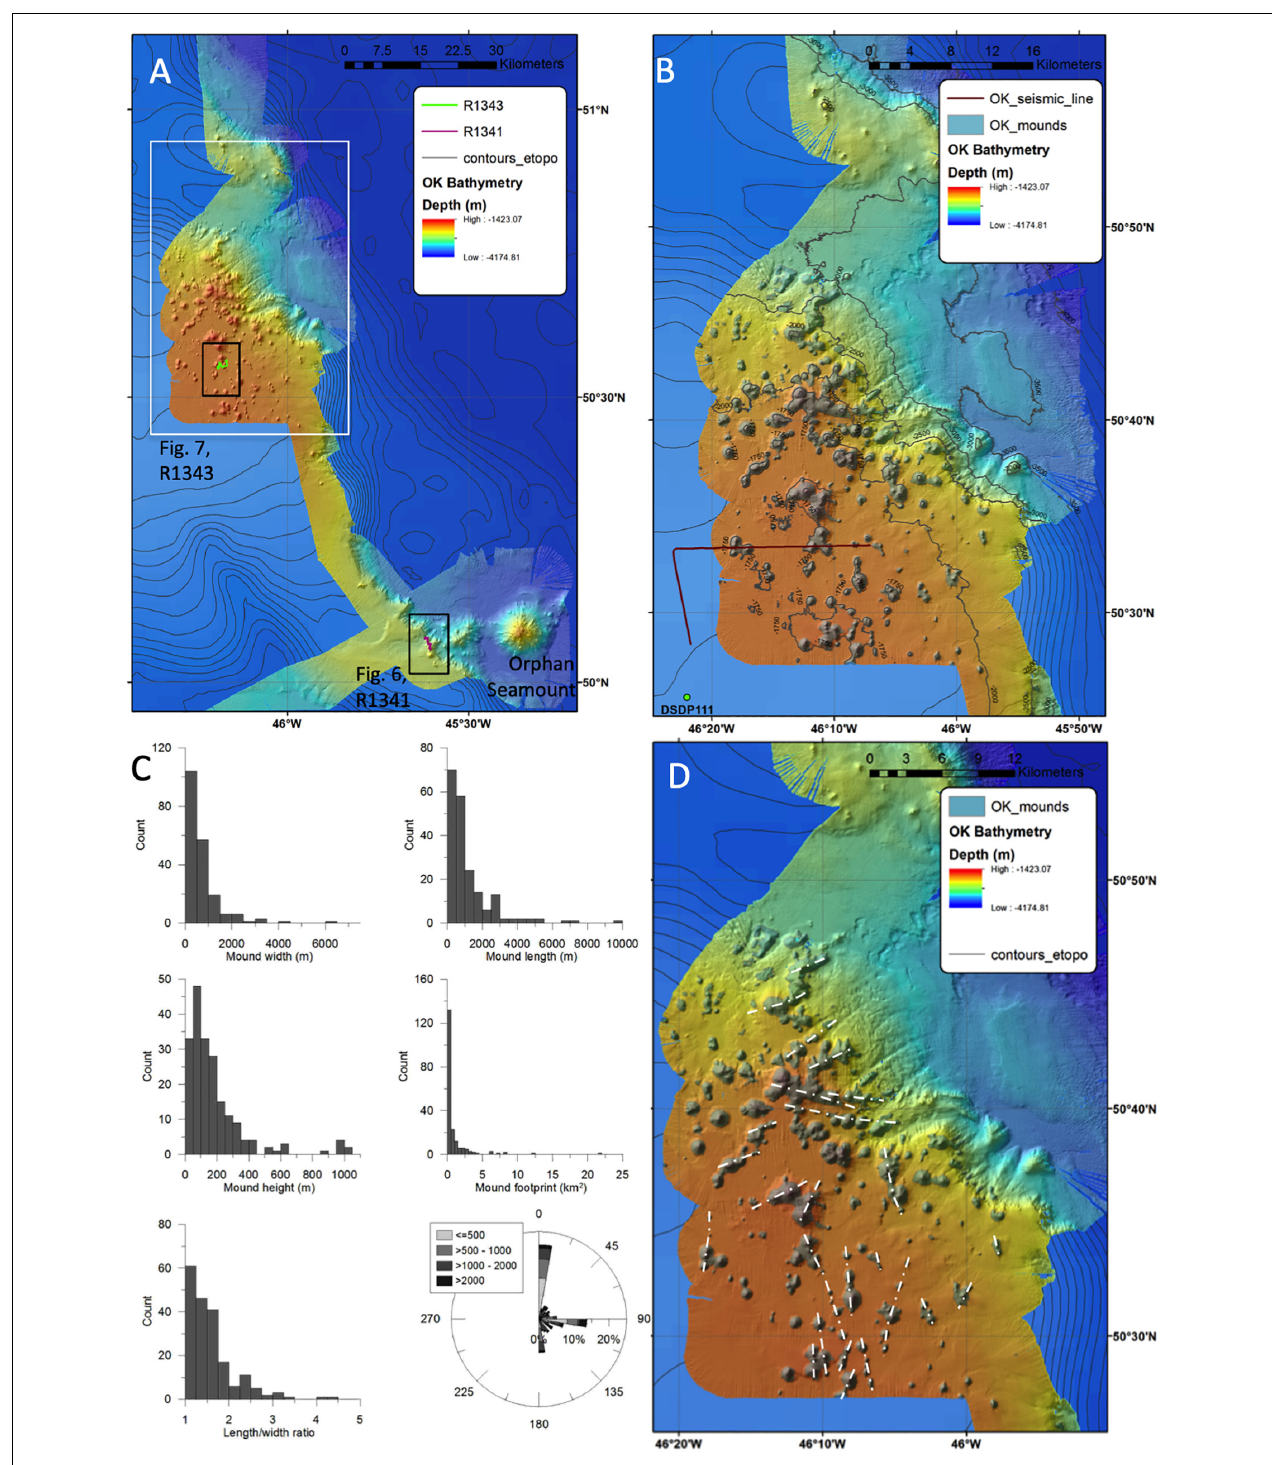
FIGURE 5 | (A) Overview map of the ICY-LAB bathymetry data set over Orphan Knoll. White box indicates are enclosed in right-hand panel (B) . Two dark boxes indicate close-up bathymetry shown in Figures 6A , 7A. (B) Zoom on the central part of the map, illustrating the results of the automated mound mapping exercise over northeast Orphan Knoll. Also shown are the locations of the sub-bottom profile line in Figure 4 , and the location of DSDP site 111. (C) Mound characteristics: histograms of mound width, length, height, footprint area, and length/width ratio. The rose diagram illustrates the orientation of mound elongation, grayscale-coded by mound length in m. (D) Speculative linear trends exhibited by groups of mounds. Trends in the southern part of the data set are parallel to the orientation of faults interpreted from seismic reflection profiles.